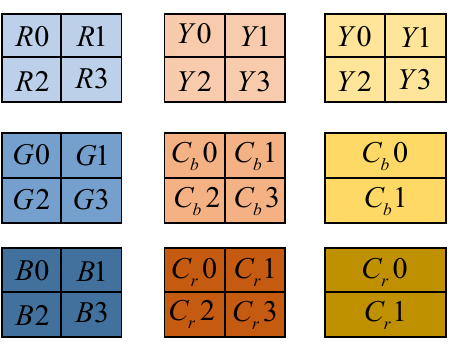
Figure 11. Image coding hidden matrix relationship.